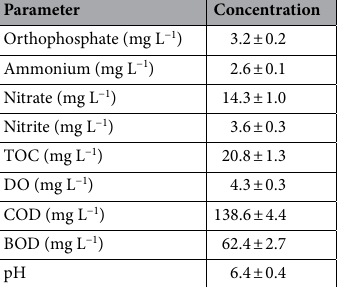
Table 1. Characteristics of aqua discharge (AD). Values were calculated as the mean (± SE) of three independent observations, i.e., n = 3.